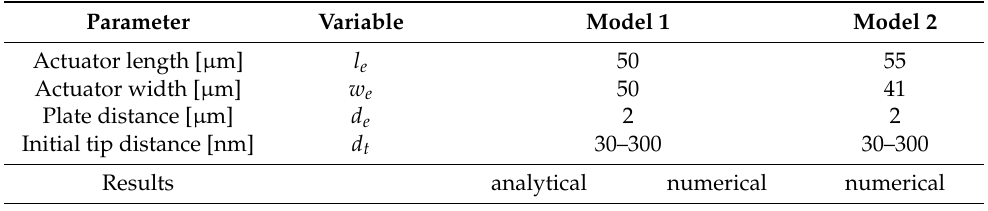
Table 4. Parameters of the electrostatic actuator.